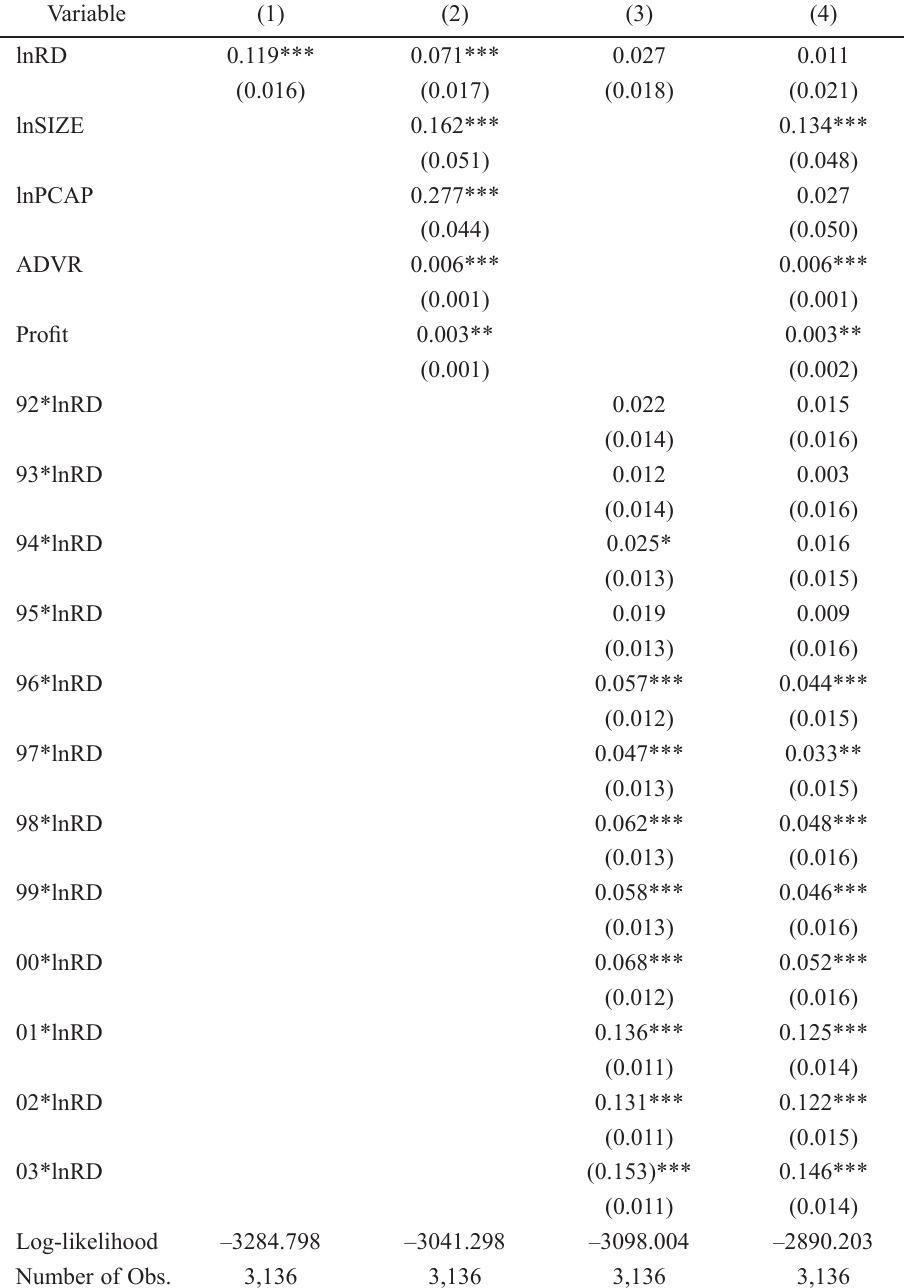
Table 4. Taiwan’s R&D productivity (FE negative binomial regression) 1991–2003